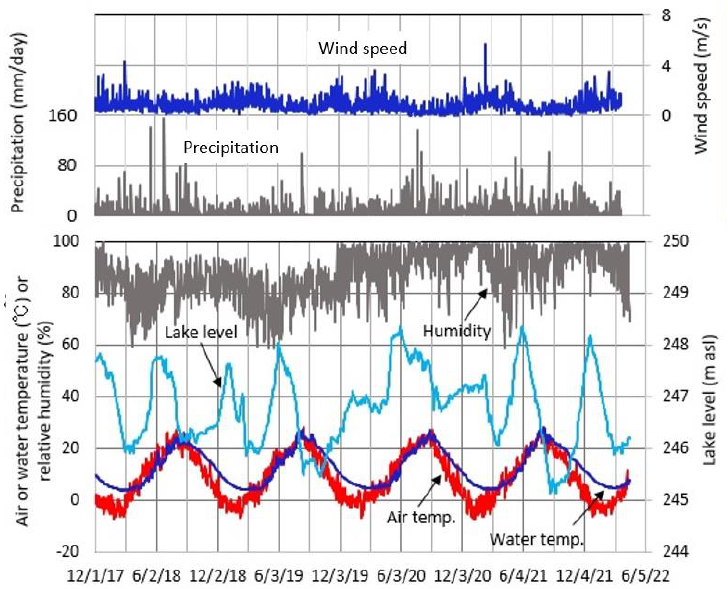
Figure 8. Temporal variations of daily mean wind speed and daily precipitation ( upper ) and daily mean relative humidity, air temperature, and water temperature at 0.2 m depth and lake level ( lower